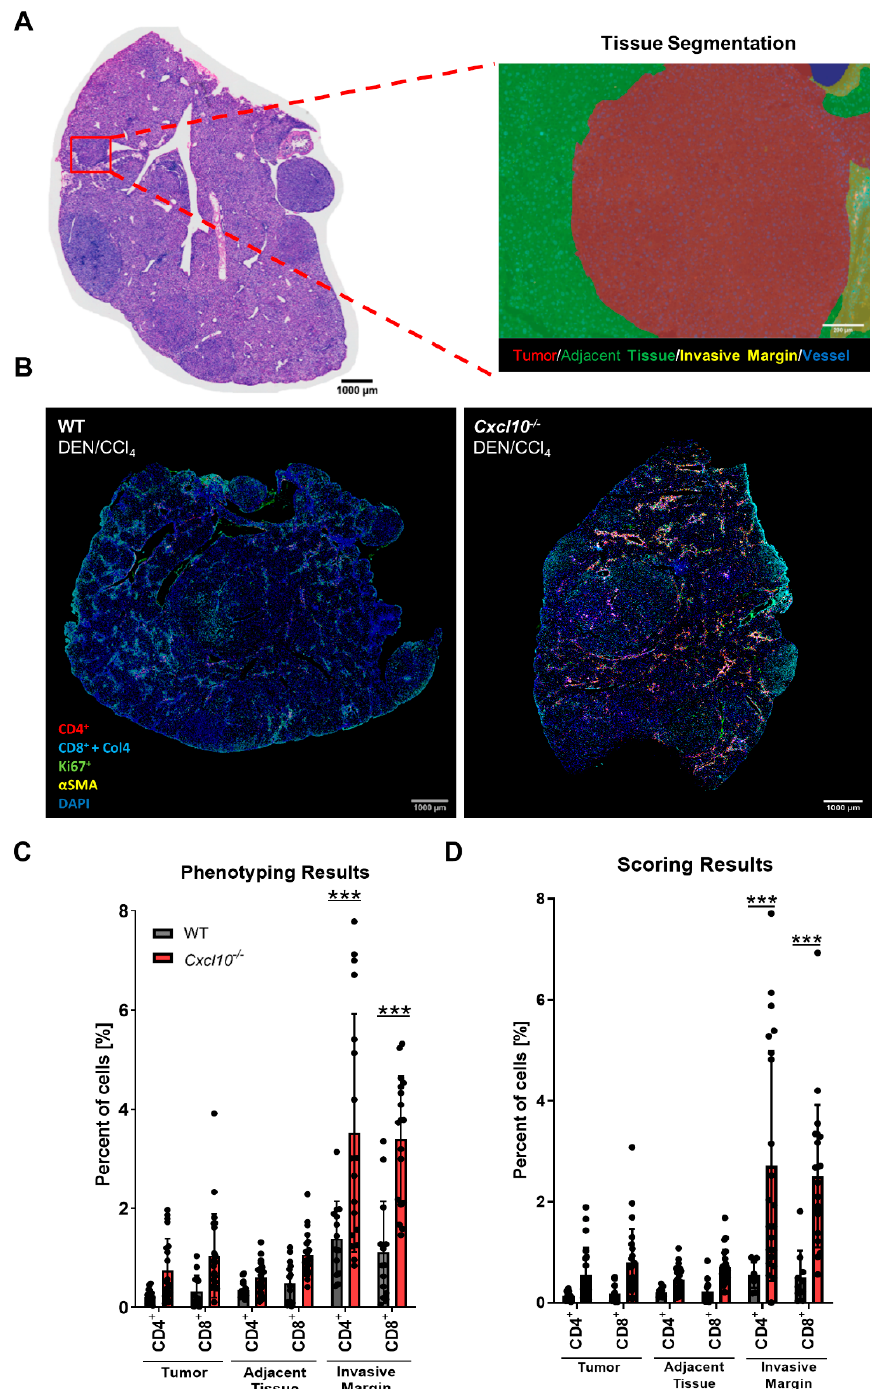
Figure 5. Deletion of Cxcl10 promotes an accumulation of T cells in the HCC invasive margin: ( A ) representative H and E staining and tissue segmentation image of tumorigenic liver tissue. Tissue segmentation into tumor tissue (red), adjacent tissue (green), invasive margin (yellow) and blood vessel (blue); ( B ) multiplex staining of tumorigenic whole slide liver scans with Ki67 (green), CD4+ cells (red), CD8+ cells and collagen 4 (cyan), Ki67+ cells (green), α SMA (yellow) and DAPI (blue) of the DEN/CCl 4 -treated WT and Cxcl10 − / − mice; ( C , D ) quantification of CD4+ and CD8+ cells in liver tissue of the DEN/CCl 4 -treated WT and Cxcl10 − / − mice, phenotyping ( C ) and scoring (%, ( D )) in different tissue regions of representative multiplex stained tissue slides using Fiji Software [21]. Data are expressed as mean ± SEM. Asterisks indicate statistical significance: *** p <